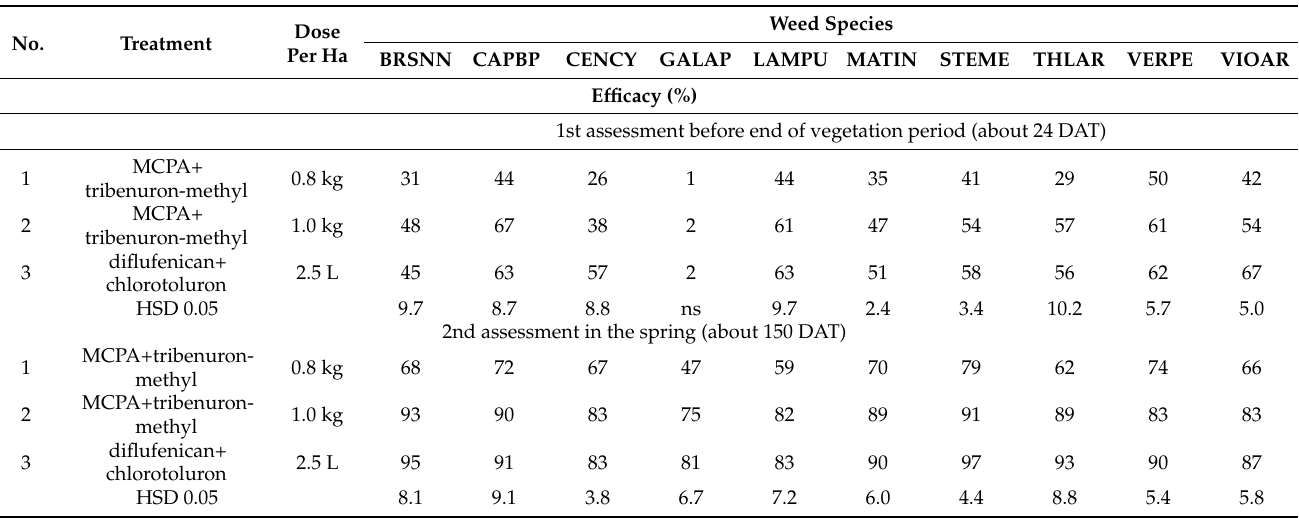
Table 4. Influence of herbicides MCPA+tribenuron-methyl and diflufenican+chlorotoluron applied in the autumn on broadleaved weed control in winter cereals in Poland.